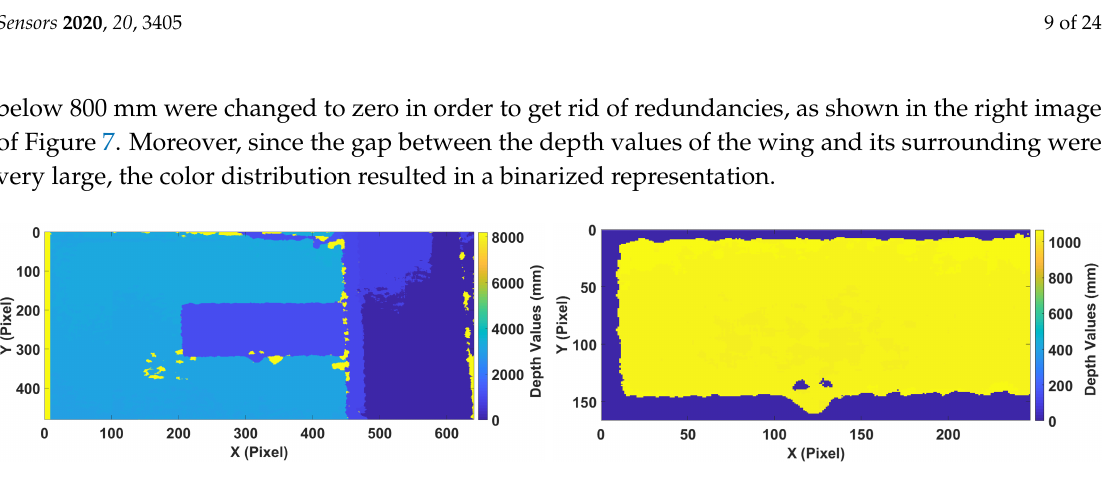
Figure 7. ( Left ) Acquired and ( Right ) Extracted depth image of the composite UAV wing.